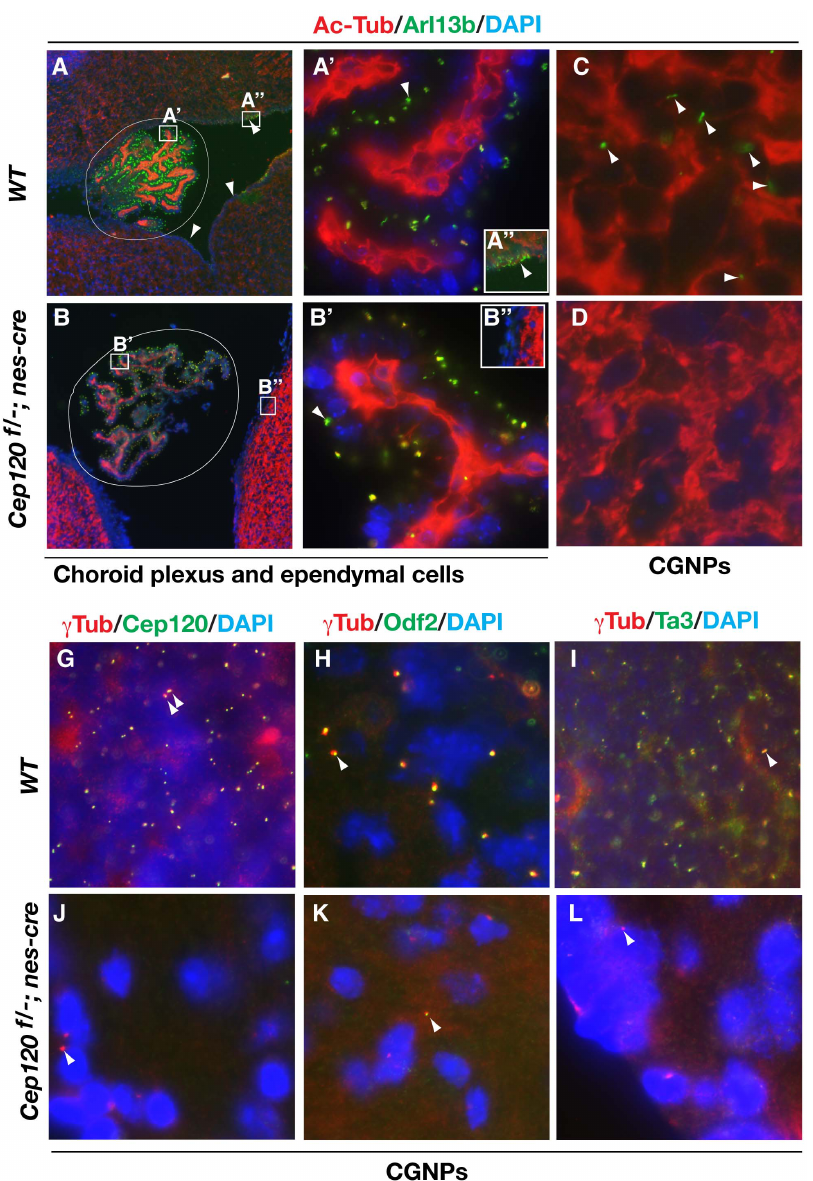
Figure 8. Failed centriole duplication, maturation, and ciliogenesis in cerebellar granule neuron progenitors (CGNPs) and ependymal cells in the Cep120 mutant. (A–D) Sagittal brain sections of P14 mice with the indicated genotypes were coimmunostained for acetylated a˜ tubulin and Arl13b, cilia markers. The fourth ventricular choroid plexus is circled. Framed areas in panels A and B are enlarged in A 9 /A 0 and B 9 /B 0 . Panels A 0 and B 0 show representative areas of ependyma near the fourth ventricle. Panels C and D show representative areas of CGNPs. Arrowheads indicate representative cilia. Note that cilia develop in the Cep120 f/- ; nes-Cre choroid plexus, but not in ependymal cells and CGNPs. (G–L) Sagittal cerebellar sections of P14 mice with the indicated genotypes were coimmunostained for c˜ tubulin and Cep120, Odf2, or Ta3, as shown. Note that very few centrioles are present in Cep120 f/- ; nes-Cre CGNPs, relative to wild type CGNPs. Arrowheads indicate one or two representative centrioles in each